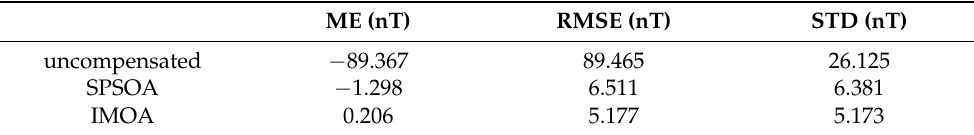
Figure 10. Compensation residual of the second group of experiment data: ( a ) comparison of total magnetic field before and after compensation; and ( b ) residual comparison after compensation. Table 5. Statistic indicators comparisons of the second group of experiment data.